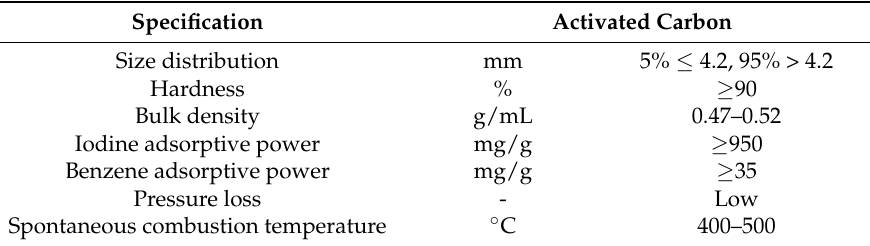
Table 5. Activated carbon